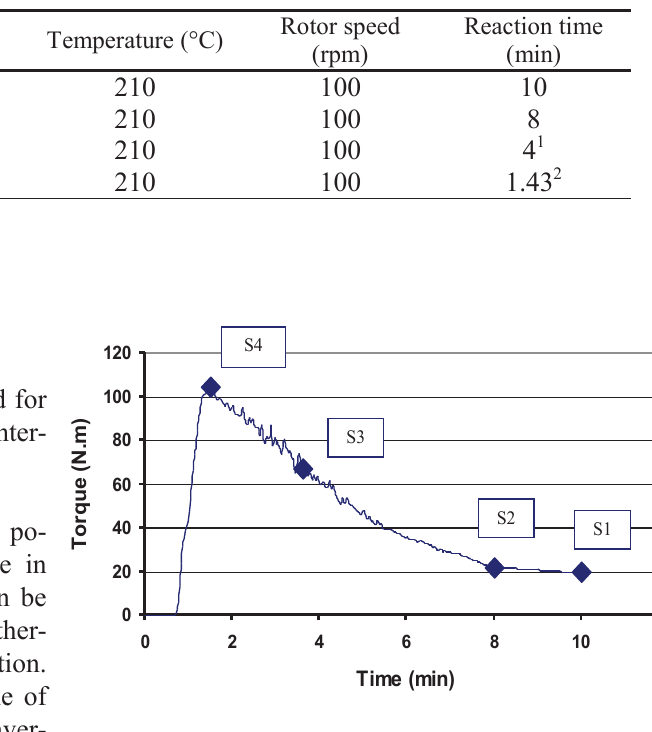
Fig. 1. Torque vs. reaction time of polymerization of ε-caprolactam at 210 °C in an internal mixer.